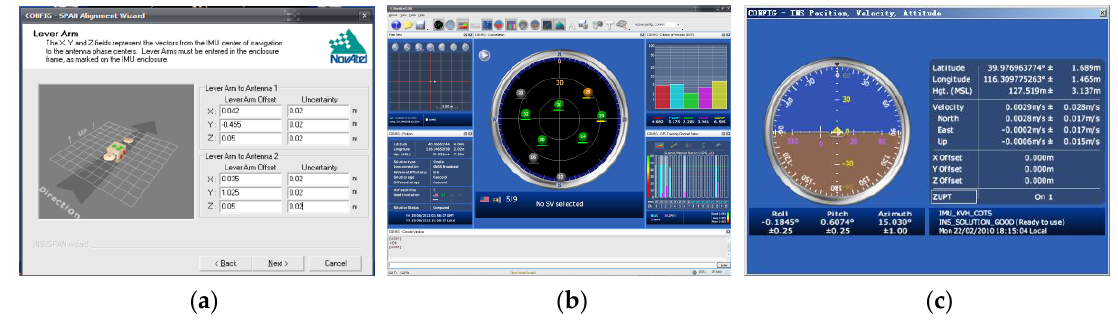
Figure 19. Interface of the GPS/INS software: ( a ) system initialization; ( b ) satellite communication; and ( c ) model state monitoring on escort yacht. and ( c ) model state monitoring on escort